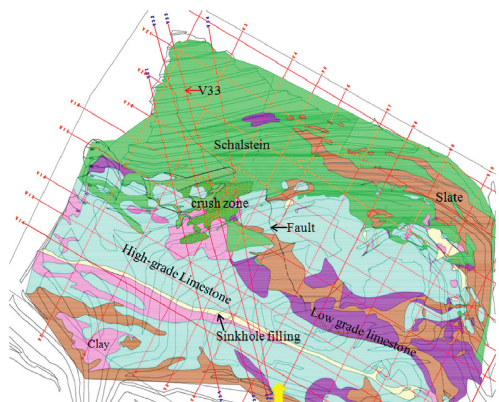
Figure 1: Geological map of the quarry. Yellow arrow shows the directional view of the rock slope’s layout in Figure